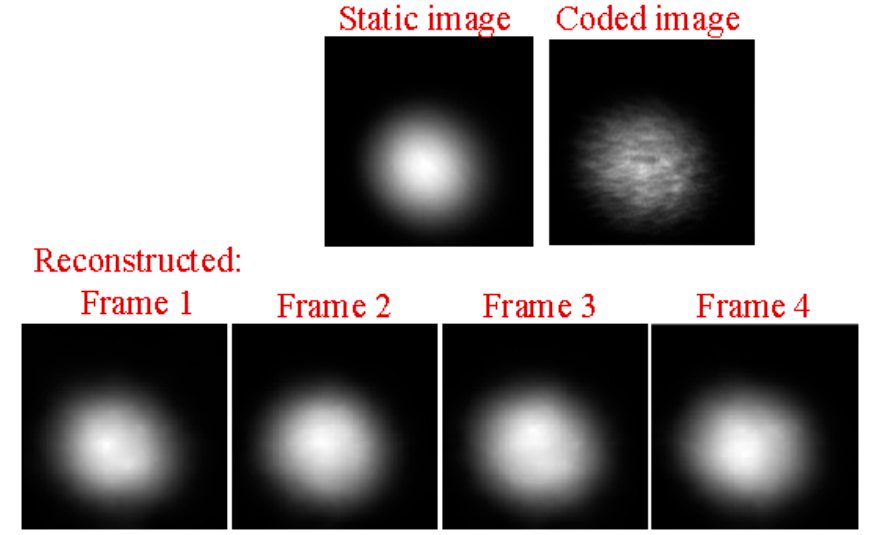
Figure 15. Top row: the left is a static light spot image; the right is a coded image at the case of 20 × compression for sound recovery. Bottom row: the first four frames of the high-speed video reconstructed from the coded image in the top row.